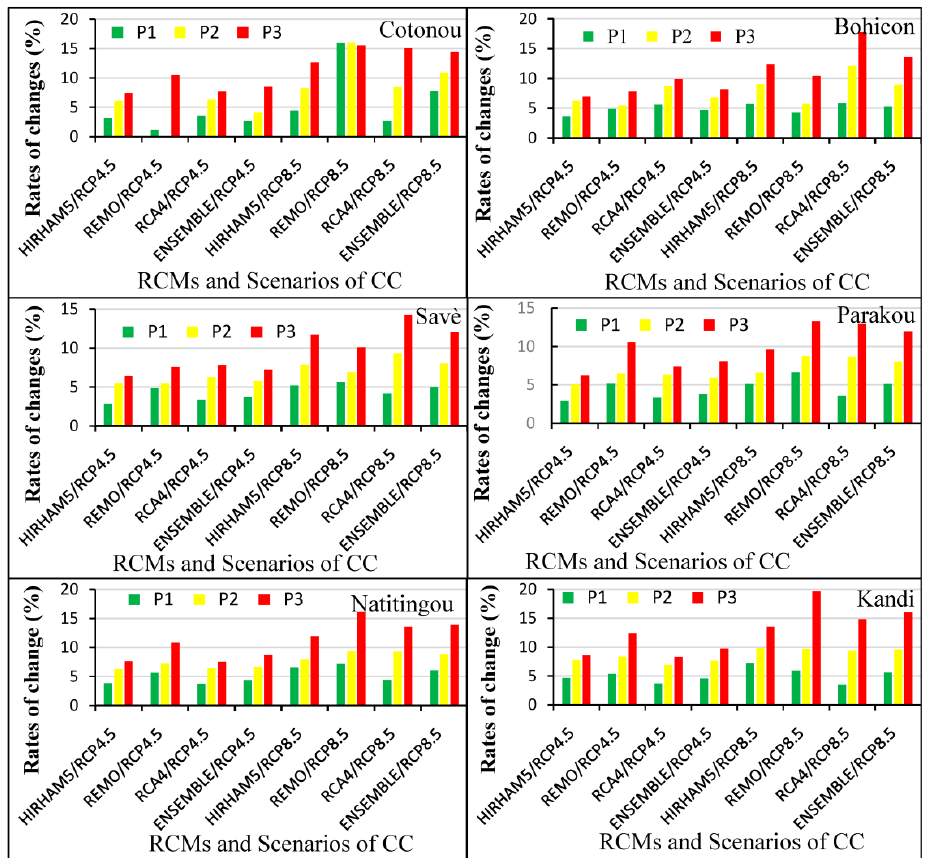
Figure 7. Rates of changes in future annual PET relative to the baseline period.